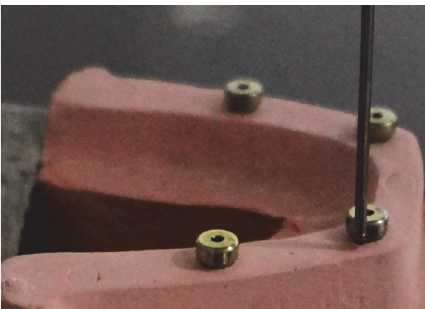
Figure 3: Measurement of coordinates of healing abutments using the CMM.